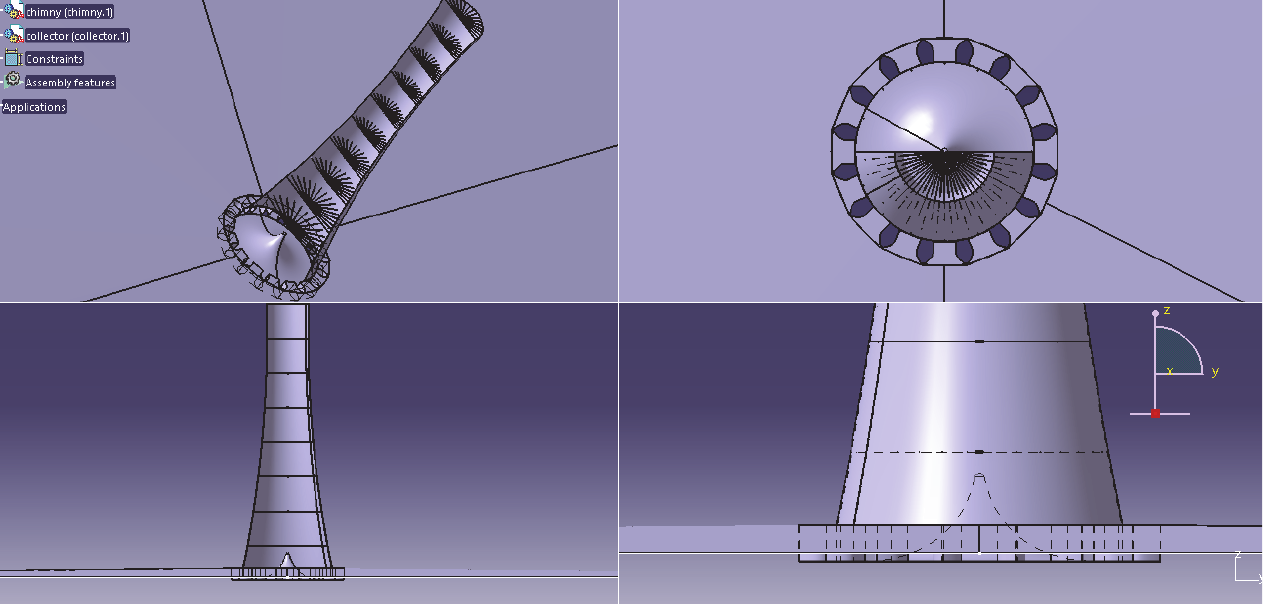
Figure 6. Assemble and section view of different components of the SUTPP, including PCU.